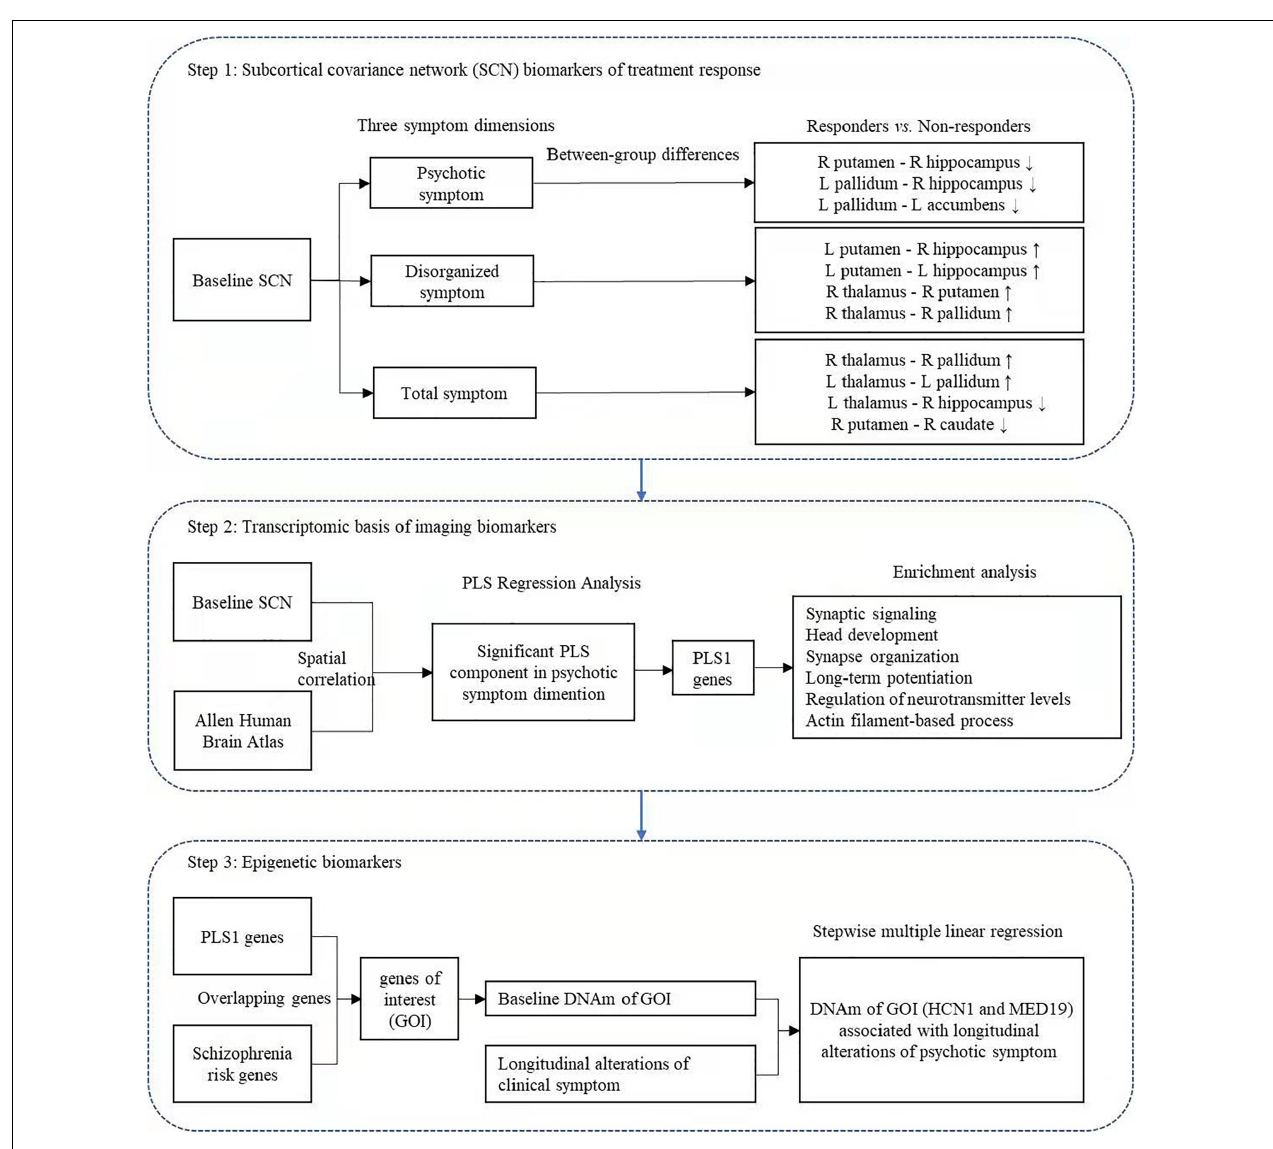
FIGURE 4 | Summary findings corresponding to the three-step multi-omic